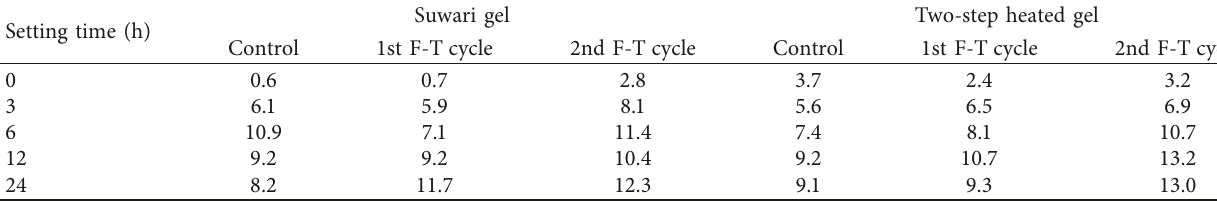
Table 1: The rate of 150kDa band against all bands in SDS-PAGE of suwari gel and two-step heated gel. Suwari gel Two-step heated gel Setting time (h)